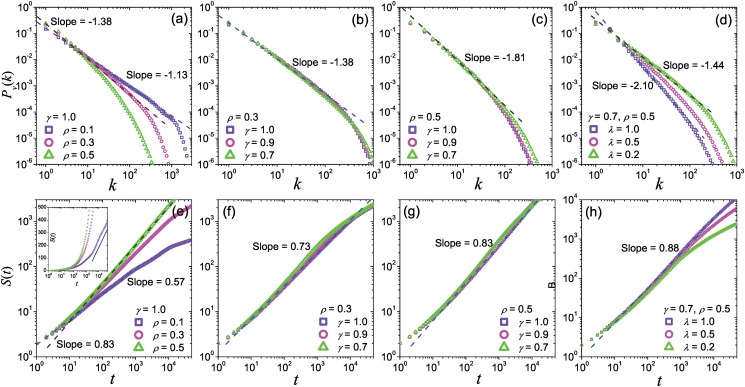
Visiting frequency distributions and the growths of the number of visited locations.Panels (a), (b), (c) and (d) are respectively the visiting frequency distributions generated by the present model with different parameters ρ and γ, as well as panels (e), (f), (g) and (h) with the growth of the number of visited locations. The result is averaged by 103 independent runs. The dark blue dashed lines and dark green dashed lines respectively corresponds to the fitting lines of the data signed by light blue squares and light green rectangles, and the blue line in the inset of (e) shows the logarithmical section.